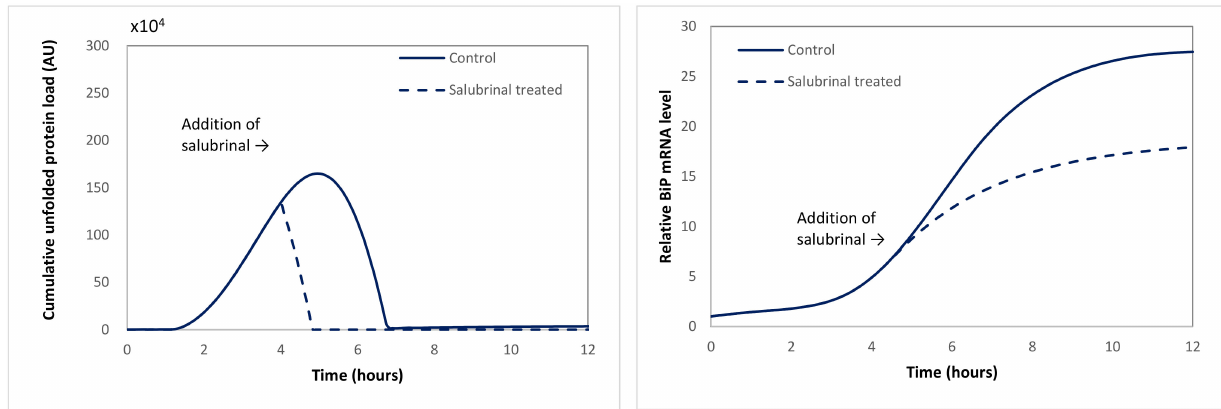
Figure 6. Effect of salubrinal on the cumulative unfolded protein load ( left ) and the BiP mRNA level ( right ) in APP S cells during Tm treatment.